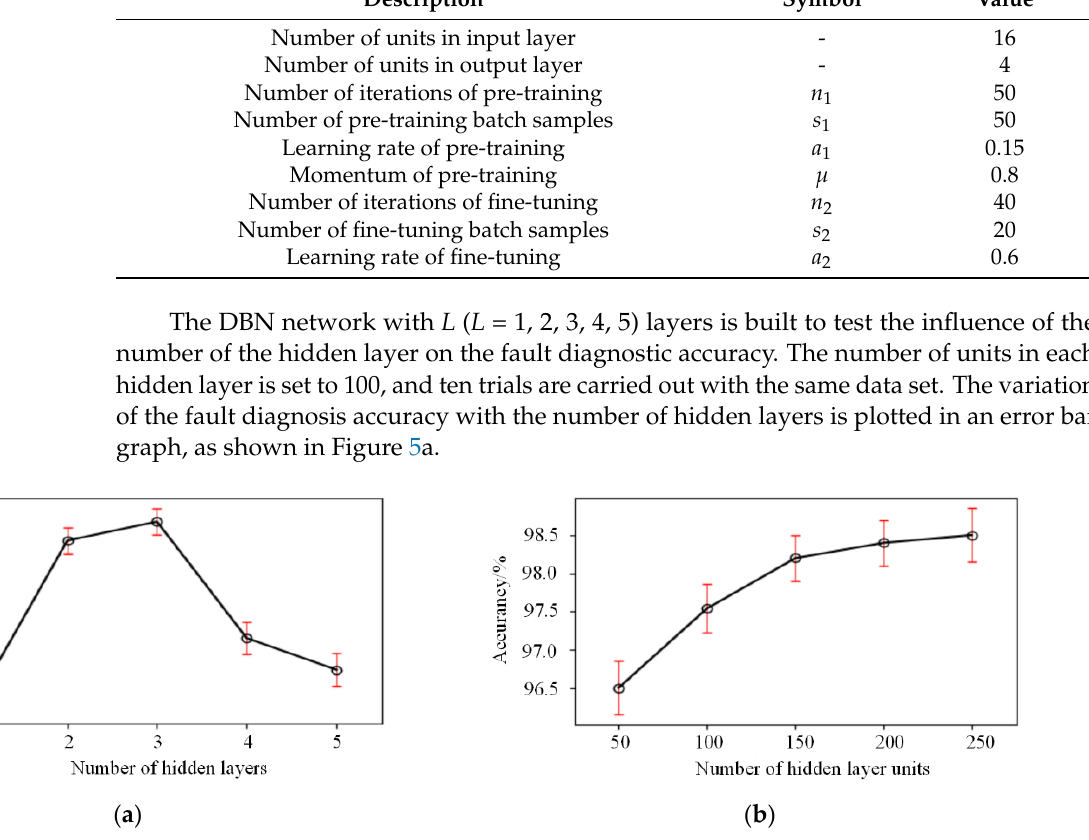
( c ) Figure 6. Recon-error of different RBM. ( a ) Recon-error of the bottom RBM. ( b ) Recon-error of the top RBM. ( c ) Recon- errors of three-layer RBMs.